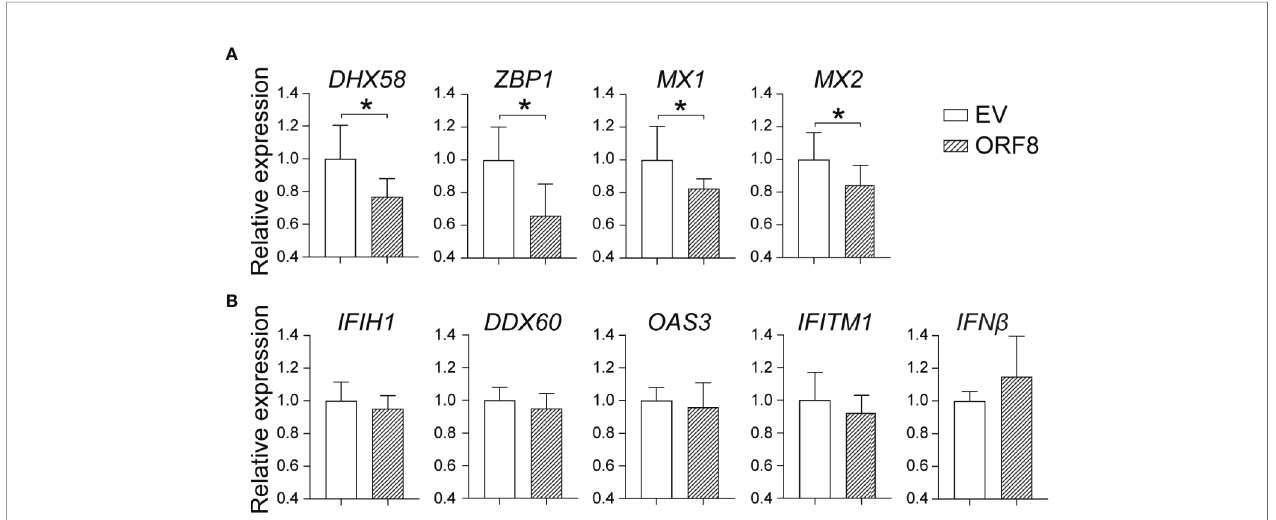
FIGURE 4 | Characterization of the role of ORF8 SARS-CoV-2 on expression of antiviral immunity-associated genes in lung epithelial cells. A549 cells were transfected with pEGFP-N1 (empty vector, EV) or pEGFP-ORF8 SARS-CoV-2 . At 24 hours post-transfection, cells were processed for RNA extraction and RT-qPCR to determine the expression levels of indicated immune response genes. (A) ORF8-inhibited genes. (B) Non-responsive genes. n = 3-5, * p < 0.05 was considered as statistically signi fi